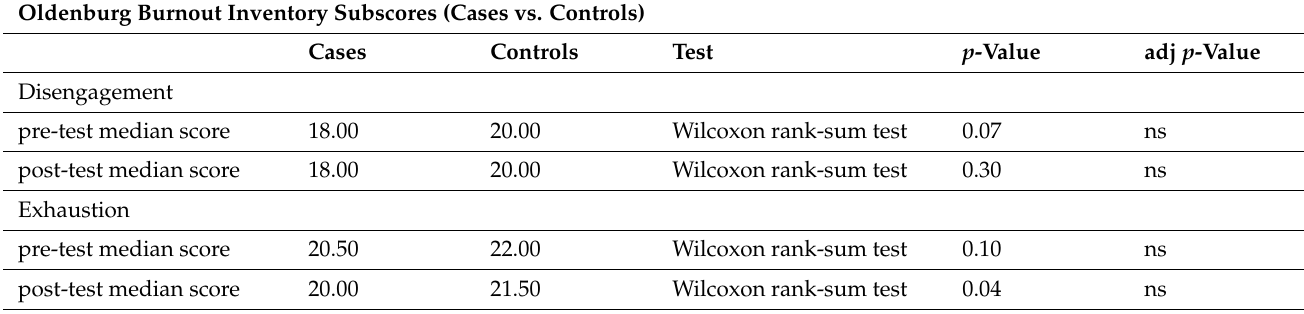
Table 3. Analysis of Oldenburg Burnout Inventory